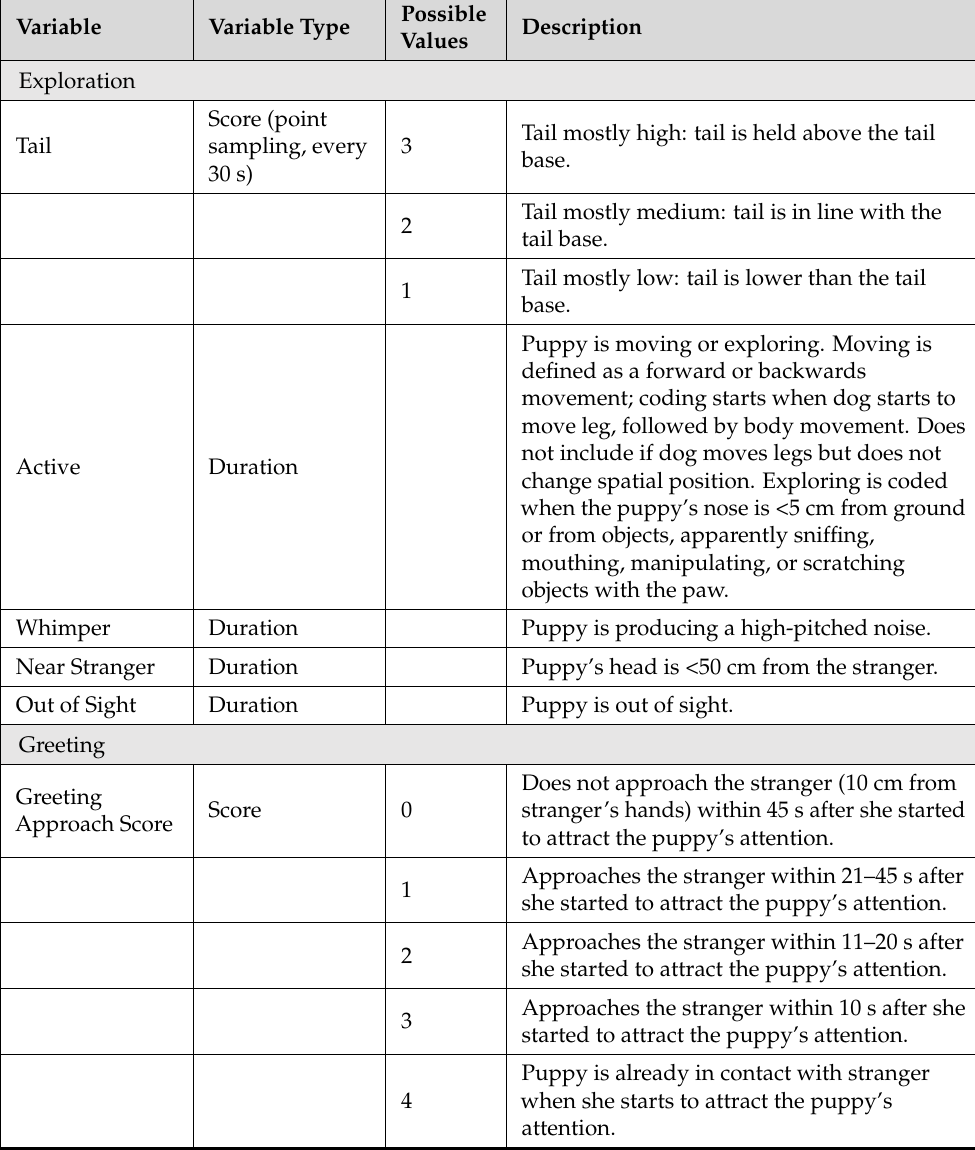
Table 4. Definitions and variable type (score/duration) of behaviours coded from the behaviour